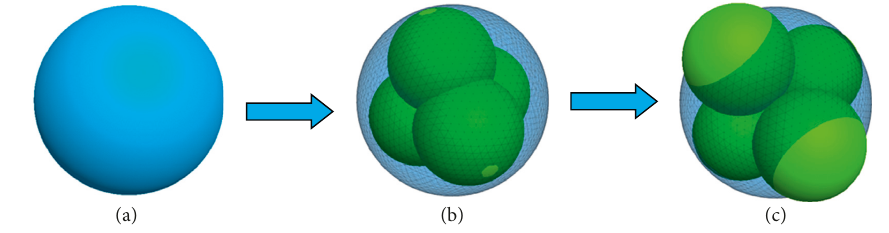
Figure 4: The configurations of postcrushing replacement.